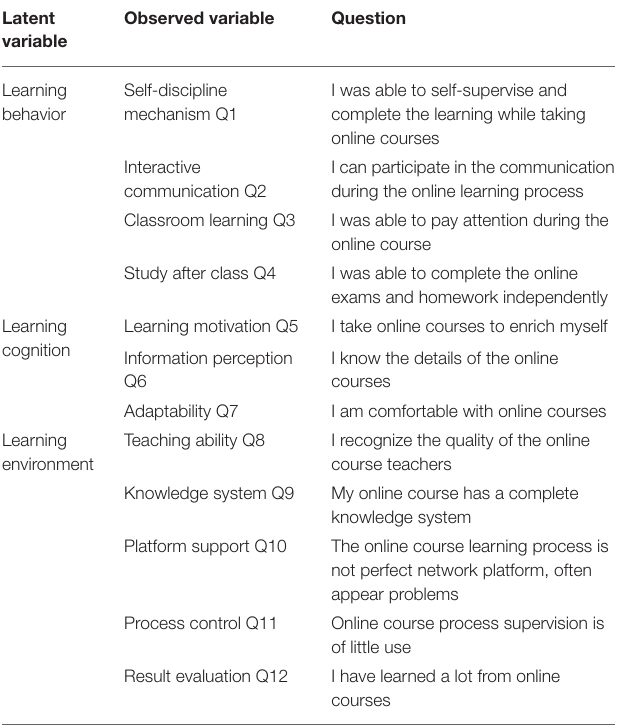
TABLE 1 | The element system of the effect of online study on college students. Latent